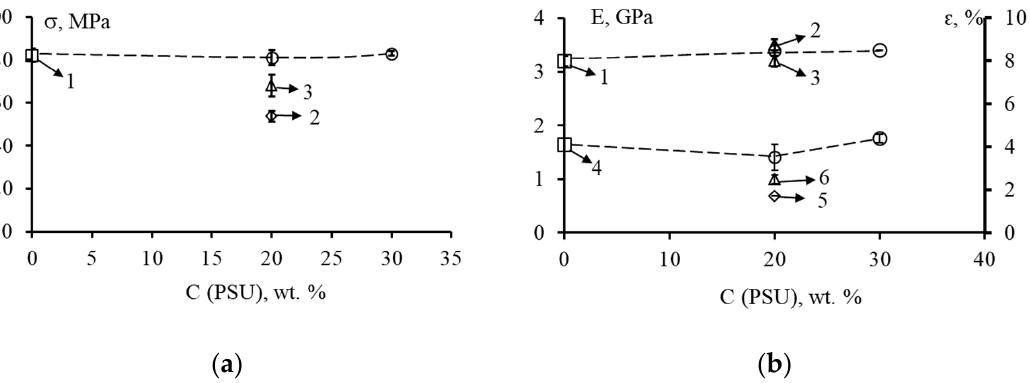
Figure 5. Strength σ , modulus of elasticity E and relative elongation ε at tension of epoxy systems EO + 20 wt. % FGE, cured iso-MTHPA, depending on the content of FGE: ( a ) 1–P0 /F0, 2–P20/F0, 3–P20/F10; ( b ) 1 and 4–P0/F0, 2 and 5–P20/F0, 3 and 6–P20/F10. In ( b ) the upper curve corresponds to the modulus of elasticity, the lower curve corresponds to the relative elongation.